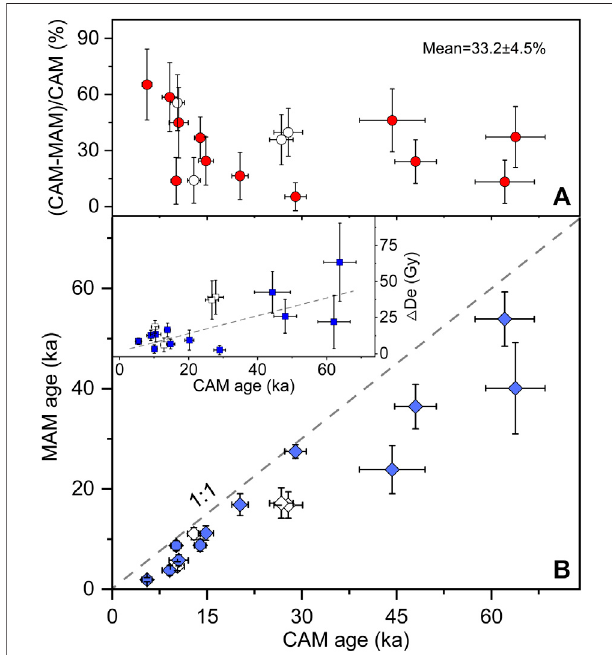
FIGURE 8 | (A) Plot of the relative difference between MAM and CAM ages as a function of the CAM ages, (B) comparison of the MAM and CAM ages, and the inset shows the difference ( △ D e ) between MAM and CAM D e values. The open points refer to loess